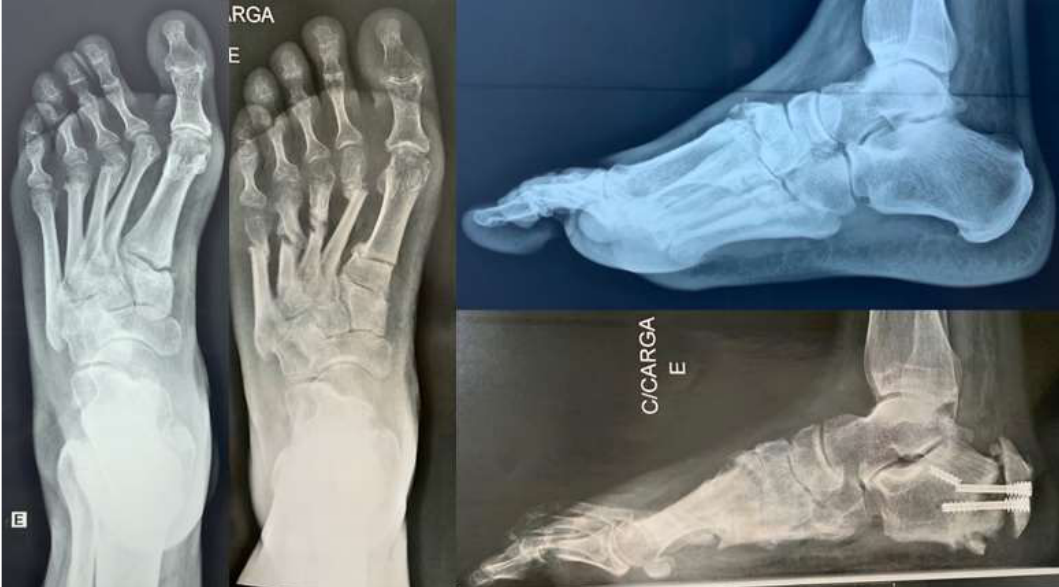
Figure 4. Delayed calcaneal consolidation in a Charcot sequela deformity.